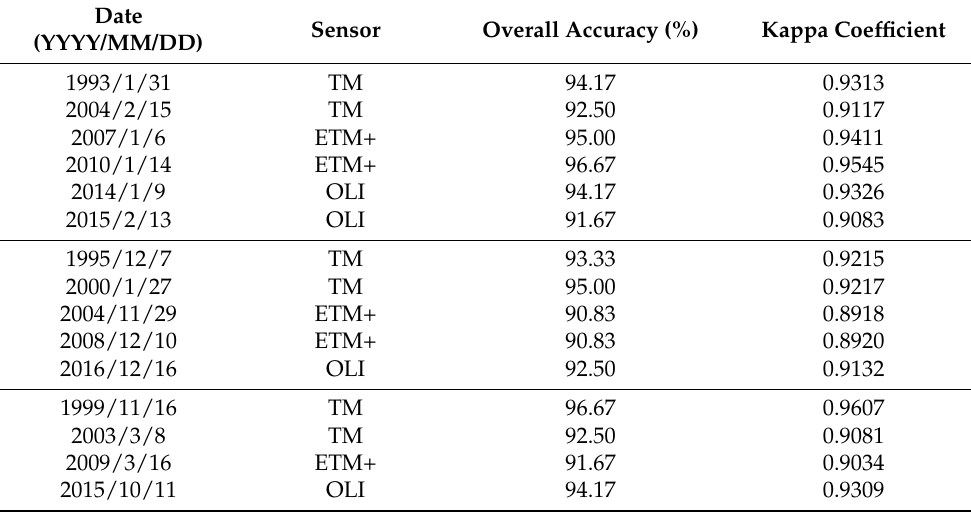
Figure 3. Poyang Lake wetland landscapes with various water levels (EL: extremely low level; LL: low level; AL: average level). Table 2. Accuracy assessment details of the wetland landscape